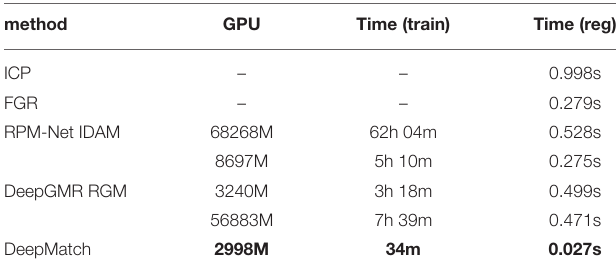
TABLE 4 | The computational resources (GPU memories) and time required for